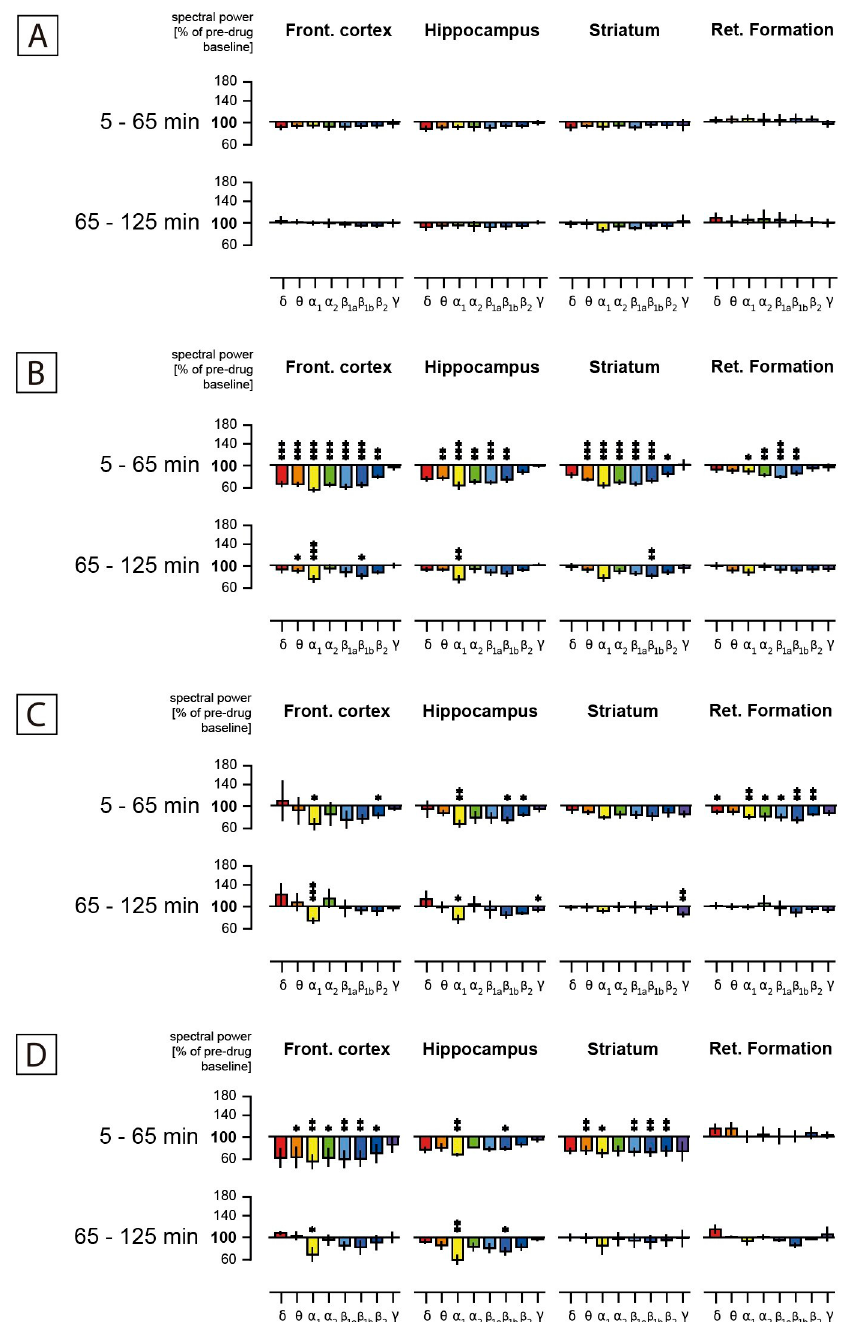
Fig 2. Effect of administration of vehicle (A), Rolipram 1 mg/kg (B), and Aframomum melegueta ethanolic extract (AME) at doses of 50 mg/kg (C) and 100 mg/kg (D): Timeline. Time dependence of spectral power changes (Ordinate) in % of 45 min lasting pre-drug baseline values in four brain regions of a freely moving rat in the presence of different tests. Frequency ranges are depicted as coloured bar graphs on the abscissa representing delta (red), theta (orange), alpha1 (yellow), alpha2 (green), beta1a (light blue), beta1b (blue), beta2 (dark blue), and gamma spectral power (violet) from left to right within the four brain areas as mentioned at the top of the graph. Statistical significance compared to control (vehicle) is documented with stars: � = p < 0.10; �� = p < 0.05; ��� = p < 0.01.